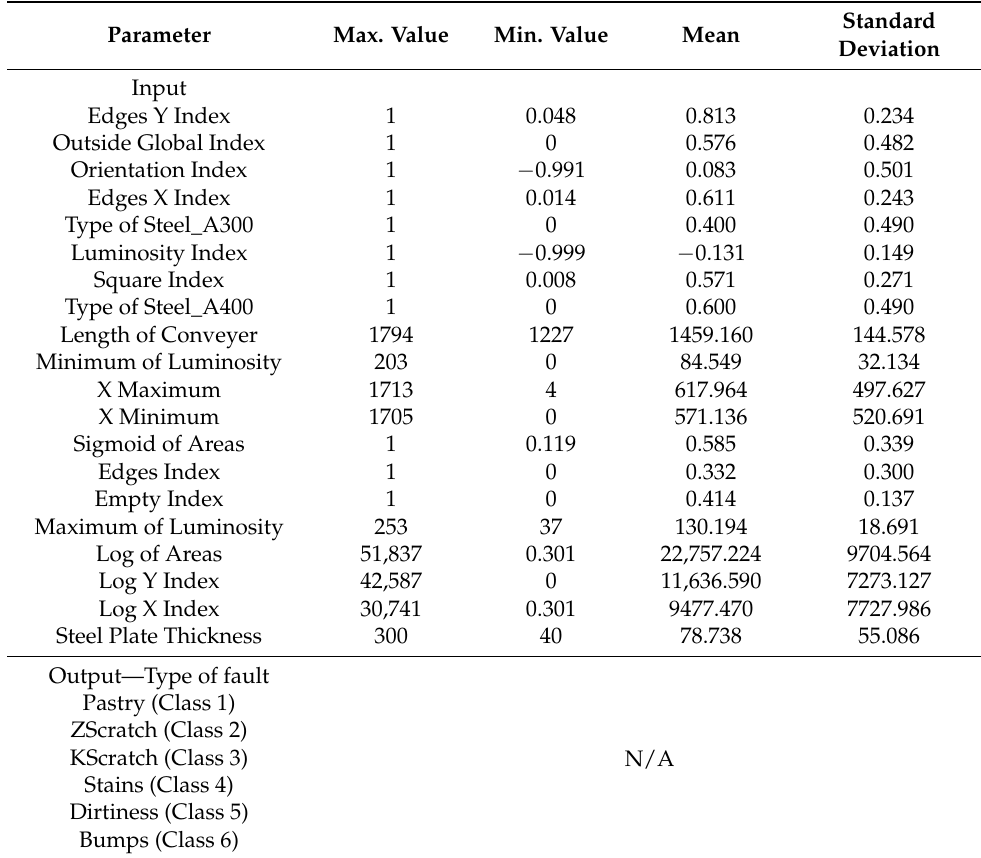
Table 6. Statistical input and profile of categorical labels for the steel plate faults diagnosis